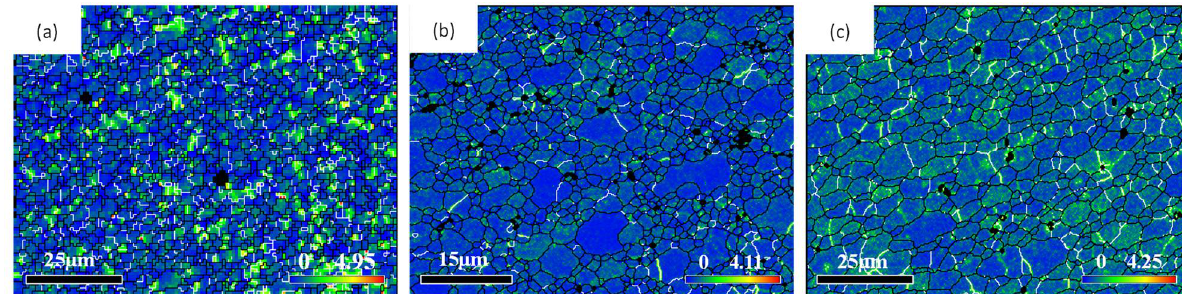
Figure 7. Kernel average misorientation diagram of the weld nugget zone at different plug rotation speeds: ( a ) 1600 rpm, ( b ) 1800 rpm and ( c ) 2000 rpm.